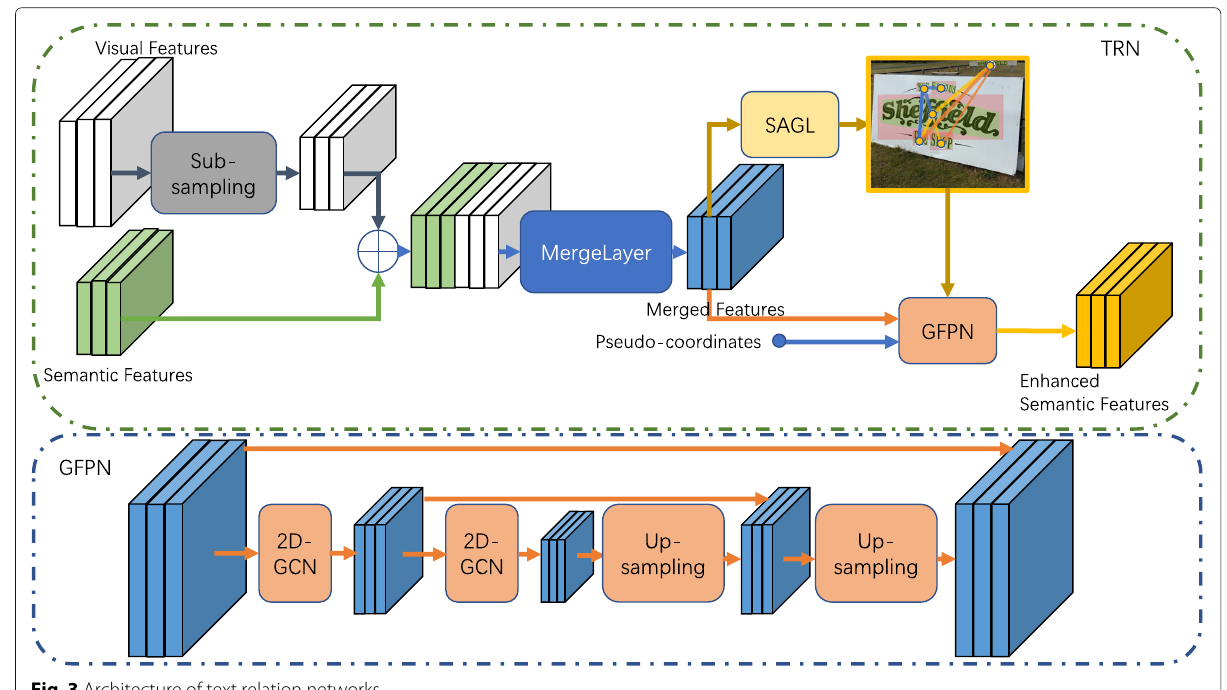
Fig. 3 Architecture of text relation